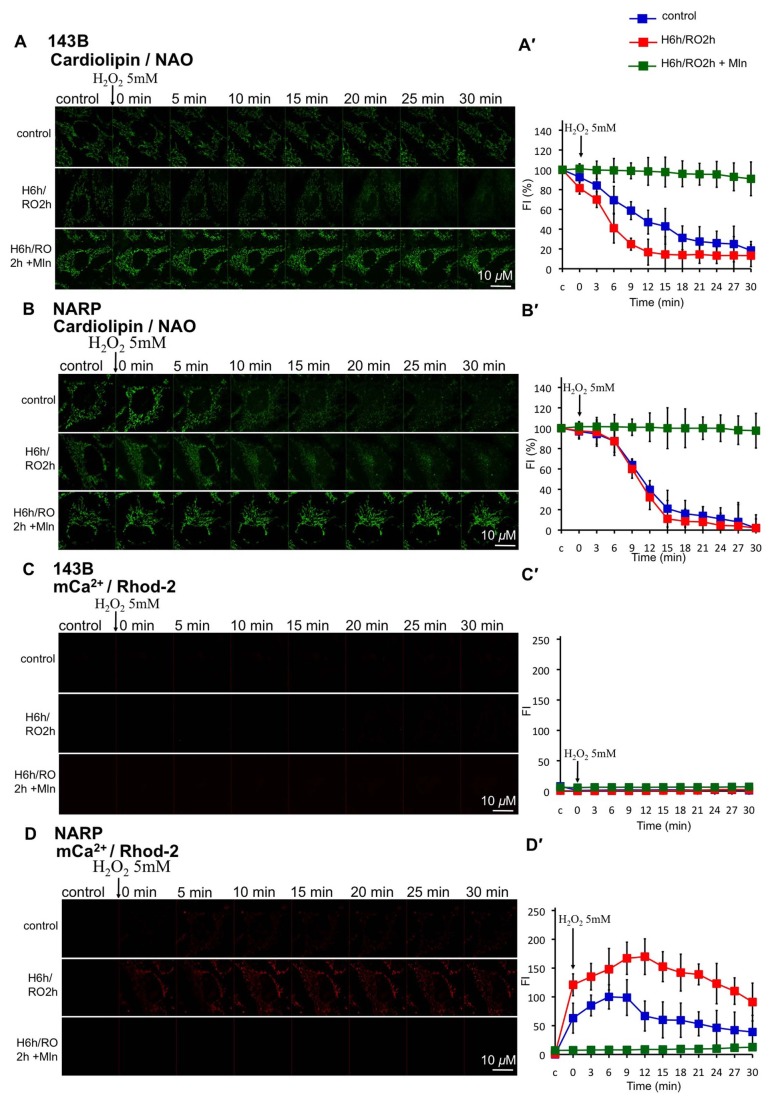
Effects of Melatonin on cardiolipin and mCa2+ upon H2O2 –augmented H/RO in 143B cells and NARP cybrids.(A) In 143B cells, cardiolipin depletion was augmented in the group with H2O2-augmented H/RO (H: 6 h; RO: 2 h). Note that adding melatonin 100 μm during H2O2-augmented H/RO protected cardiolipin from depletion. (B) In NARP cybrids, cardiolipin depletion was augmented as compared with 143B cells, and adding melatonin during H2O2-augmented H/RO protected cardiolipin from depletion. (C) In 143B cells, no obvious mCa2+ accumulation was noted in response to H2O2-augmented H/RO. (D) In NARP cybrids, mCa2+ accumulation was augmented in the group with H2O2-augmented H/RO. Adding melatonin during H2O2-augmented H/RO suppressed mCa2+accumulation. (A′-D′) Quantitative analyses of A-D. n=6. Mln: melatonin.